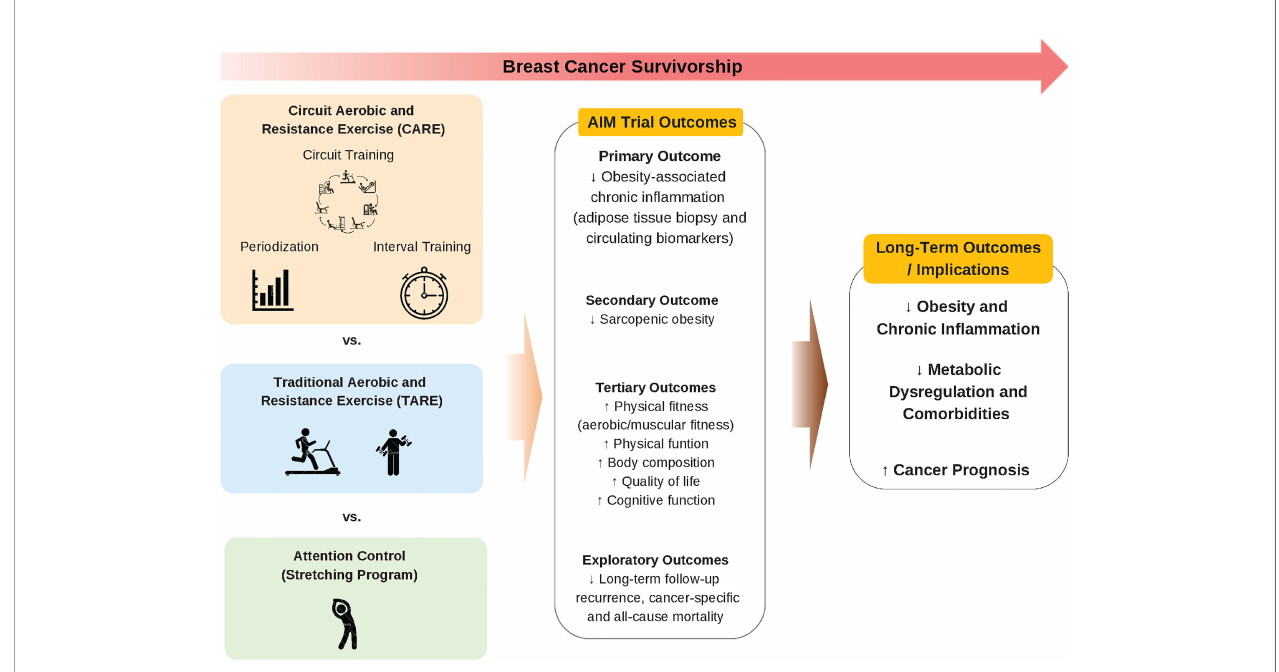
FIGURE 1 | Conceptual framework of the AIM